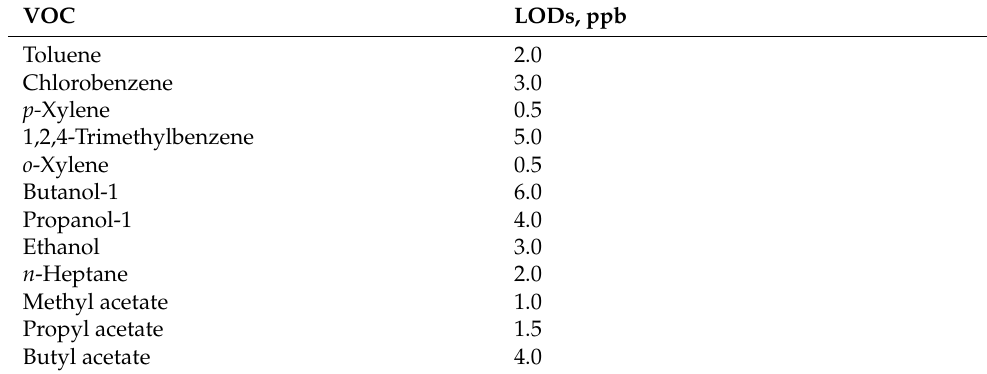
Figure 5. Background corrected mass spectrum range of propionic acid obtained using air glow discharge. Acquisition parameters were as follows: discharge pulse duration 1.1 µ s, discharge period 900 µ s, discharge pressure 133 Pa, repelling pulse delay 200 µ s; concentration of propionic acid of 70 ppm. Table 2. Limits of detection (LODs) of VOCs in the air. The measurement conditions were as follows: acquisition time 10 min, discharge pulse duration 1.1 µ s, discharge period 900 µ s, discharge pressure 133 Pa, repelling pulse delay 200 µ